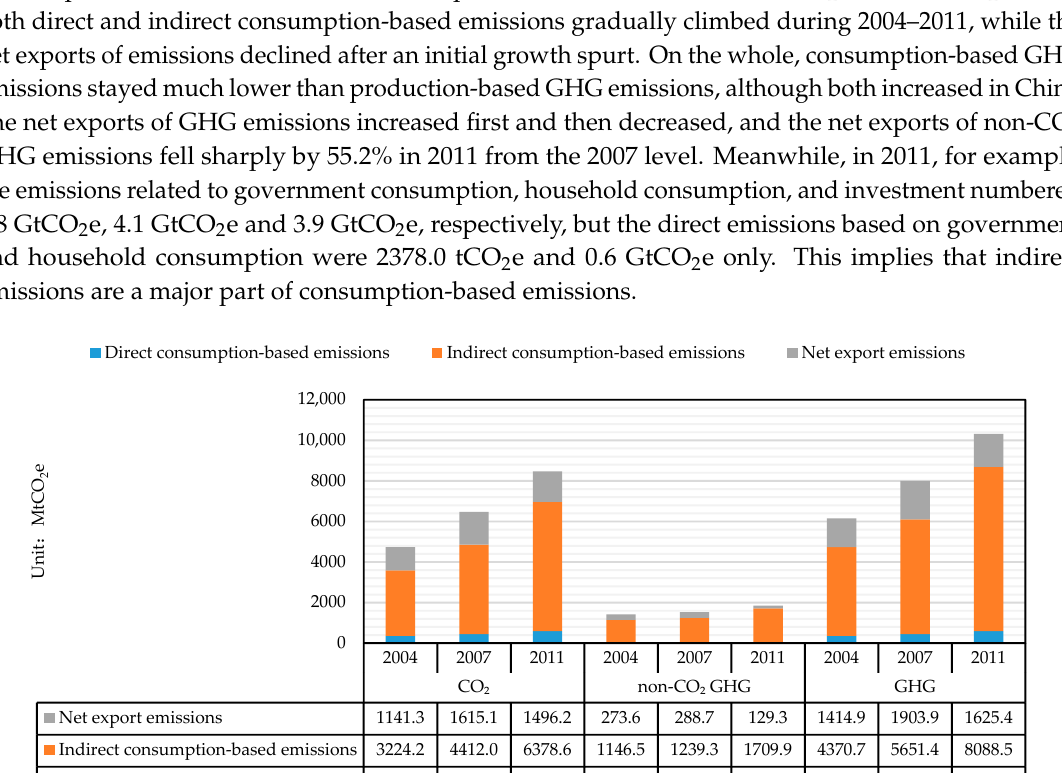
Table 1. China's GHG emissions in 2004, 2007 and 2011.